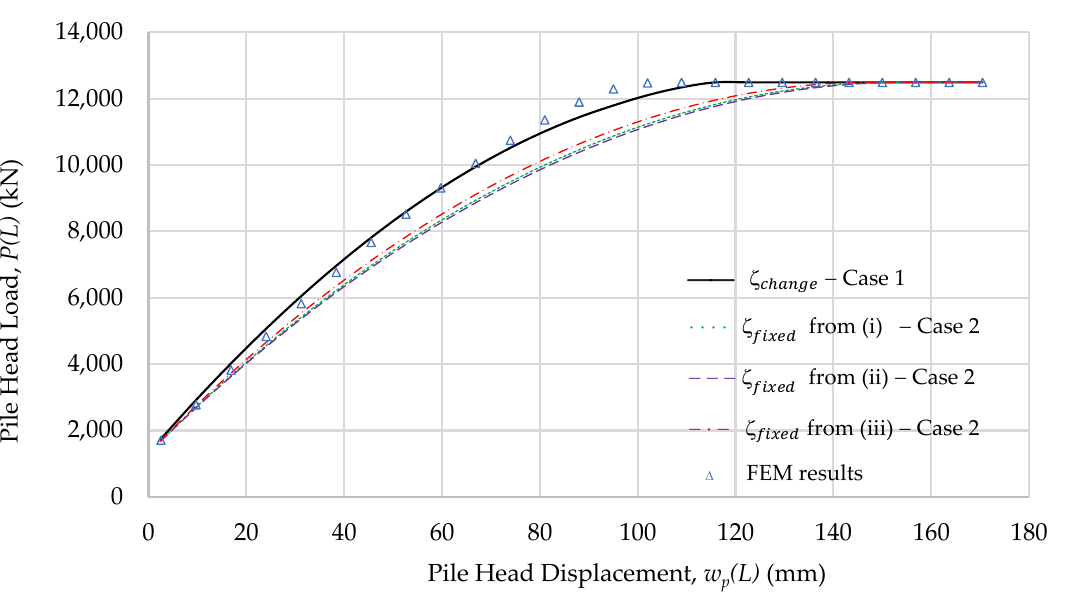
Figure 15. Pile head load versus pile head displacement, improvement of the load–displacement curve ( 𝐿⁡ = 30 m, 𝐿/𝑟 0 ⁡= 40 and 𝐺⁡ = ⁡3846⁡ kPa).